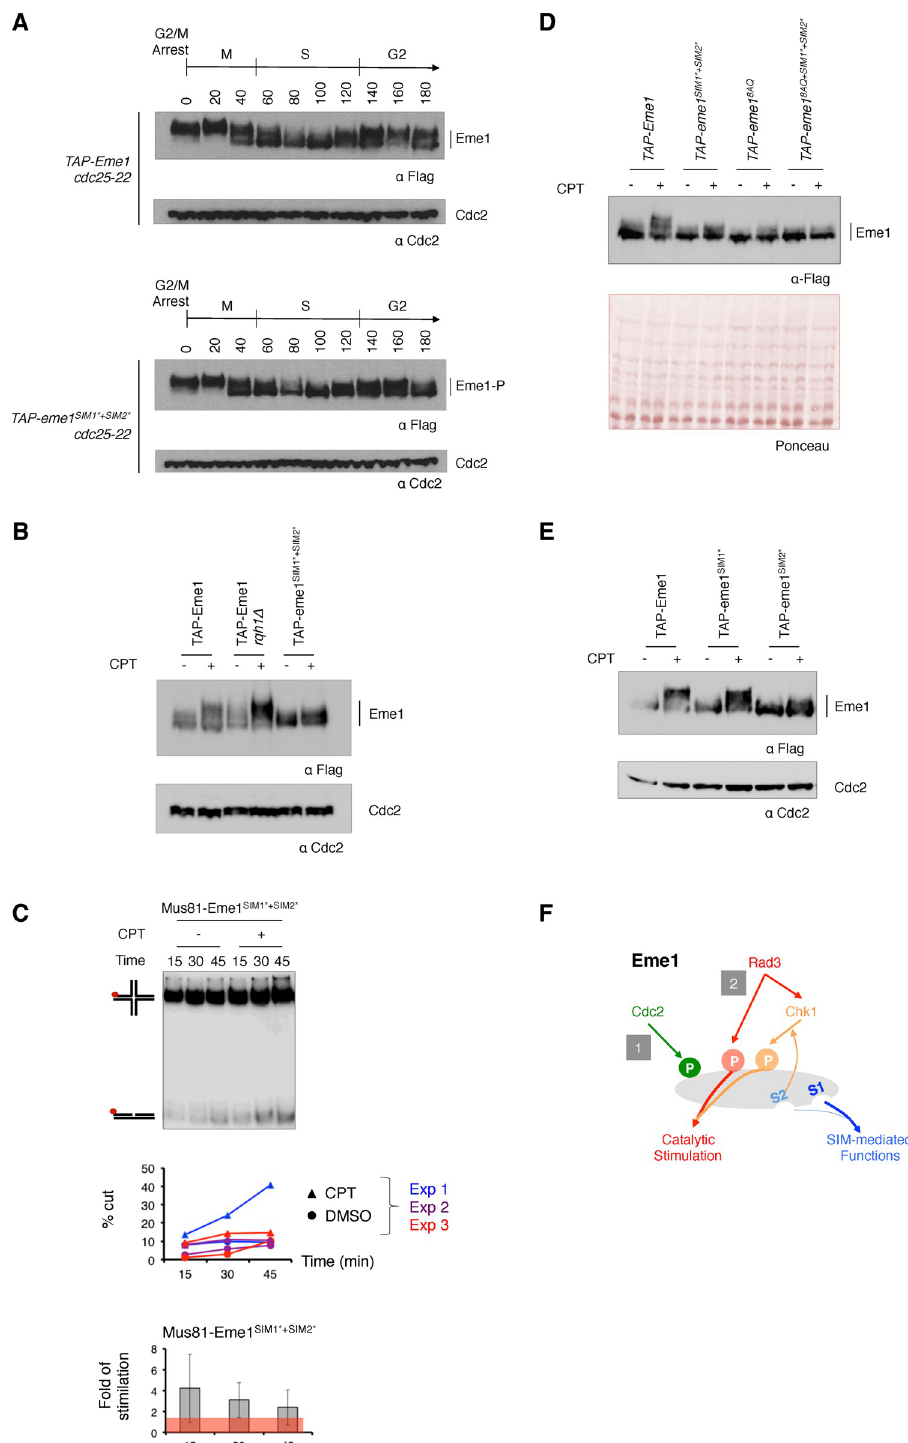
Fig 6. Mutations within the SIMs differently affect Eme1 phosphorylation. A- Western blot detection of TAP-Eme1 from cdc25-22 TAP-eme1 and cdc25-22 TAP- eme1 SIM1 � +SIM2 � synchronized at the G2/M transition and released for one cell cycle. Total proteins were extracted at each indicated time point of the time course and analyzed by Western blot using an antibody raised against the Flag tag of TAP-Eme1. Cdc2 is used as a loading control. B- Western blot detection of TAP-Eme1 from untreated or 40 μ M CPT–treated WT, rqh1 Δ and eme1 SIM1 � +SIM2 � cells. Cdc2 is used as